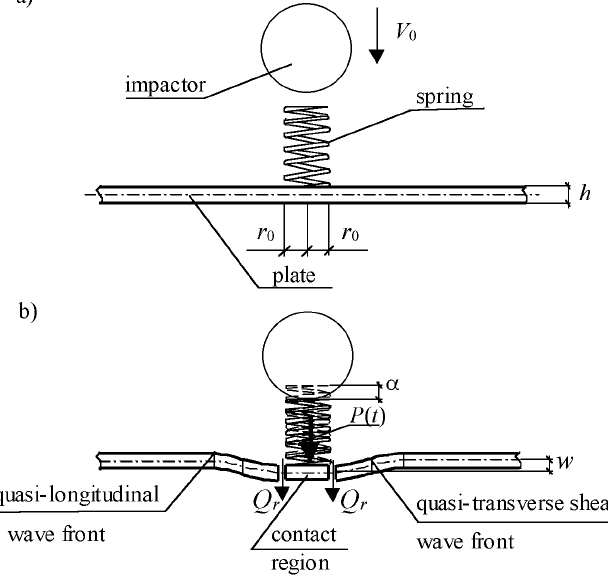
Fig. 1. Scheme of the shock interaction of an impactor with a plate: (a) before impact, and (b) after impact. critical values (these critical values were less than the critical values of the compression forces under which the plane form of equilibrium of the plate became unstable), then the normal displacements of some set of points possessed by the plate might take on rather large values in a small instant of the